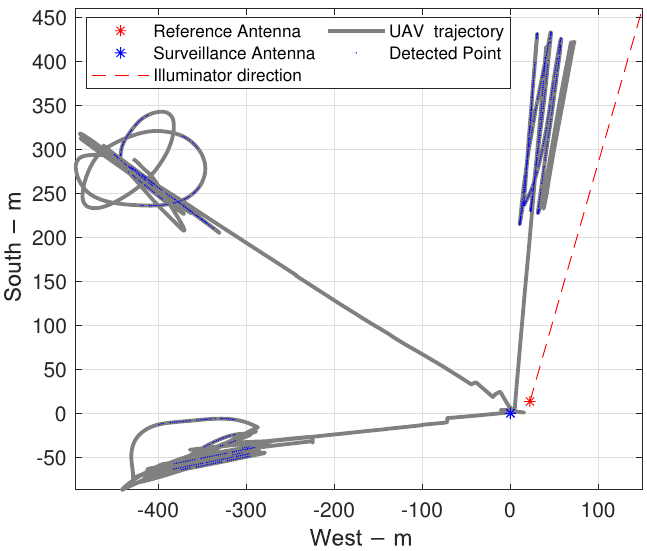
Figure 10. Diagram of the system’s detectable